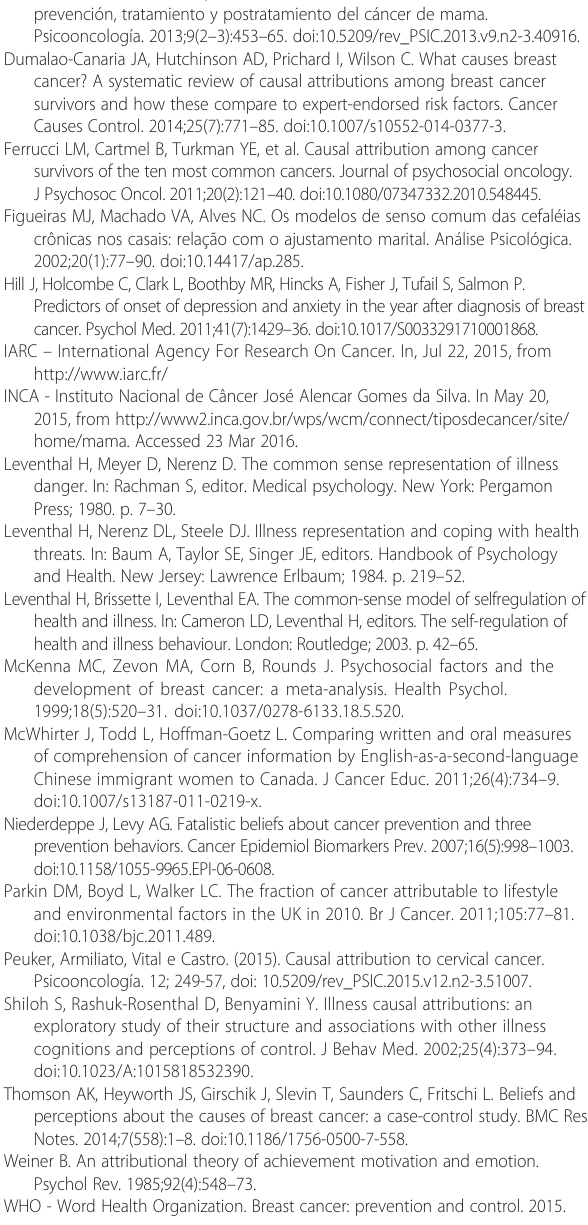
Figueiras MJ, Machado VA, Alves NC. Os modelos de senso comum das cefaléias crônicas nos casais: relação com o ajustamento marital. Análise